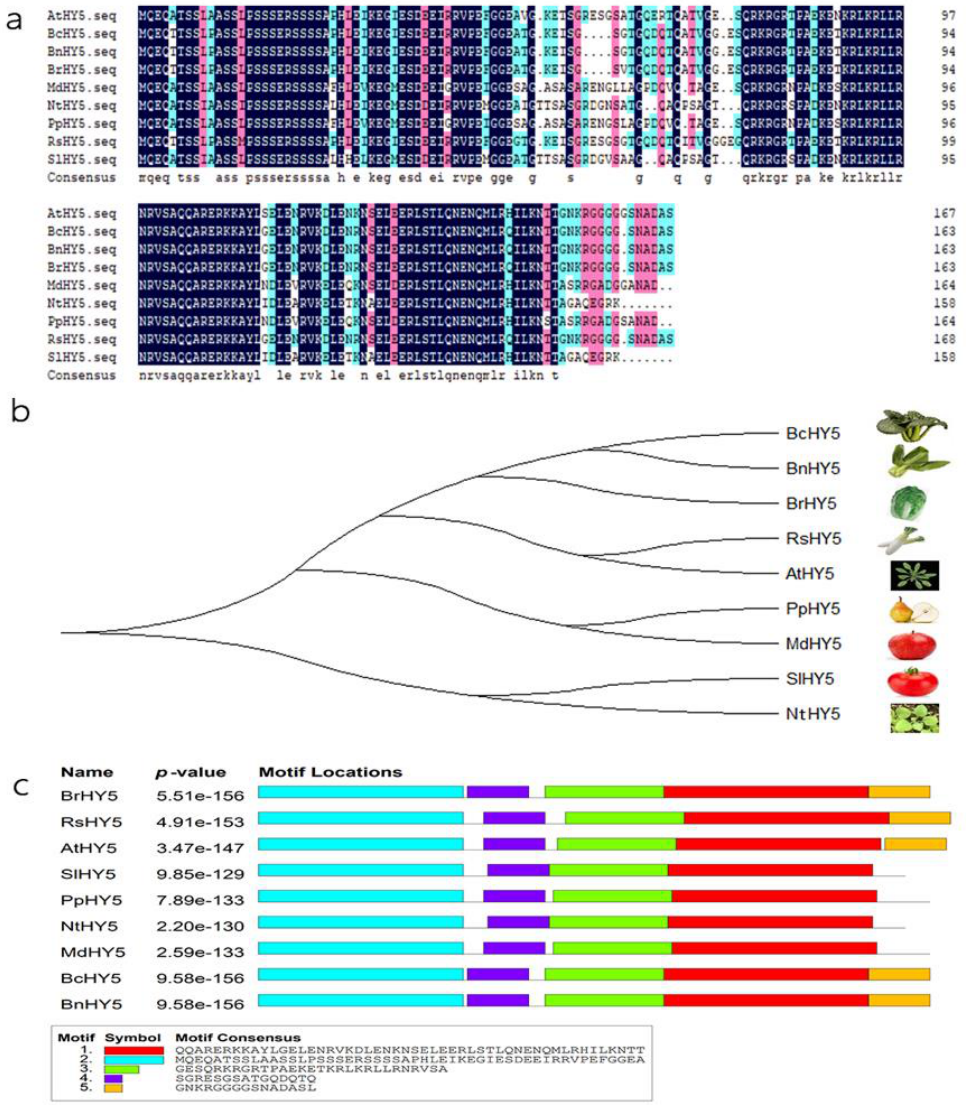
Figure 1. The characteristics of BcHY5 protein. ( a ) Amino acid sequence alignment of HY5-like proteins in Brassica oleracea (BoHY5, XP_013609113.1), Raphanus sativus (RsHY5, NP_001330553.1), Brassica rapa (BrHY5, XP_009121971.1), Arabidopsis thaliana (AtHY5, NP_568246.1), Solanum lycopersicum (SlHY5, NP_001234820.1), Malus domestica (MdHY5, NP_001280752.1), Nicotiana tabacum (NtHY5, OIT35567.1), and Pyrus ssp (PpHY5, QRR19189.1). ( b ) HY5 phylogenetic analysis in different species. ( c ) The motif analysis of HY5. The relevant sequence information is shown at the bottom of the figure, and the p -value represents the significance of each motif.